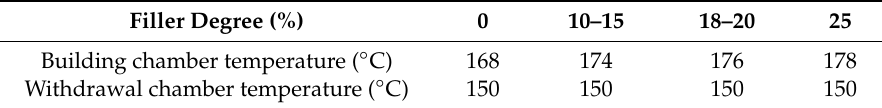
Table 2. Used building chamber temperature for the composite